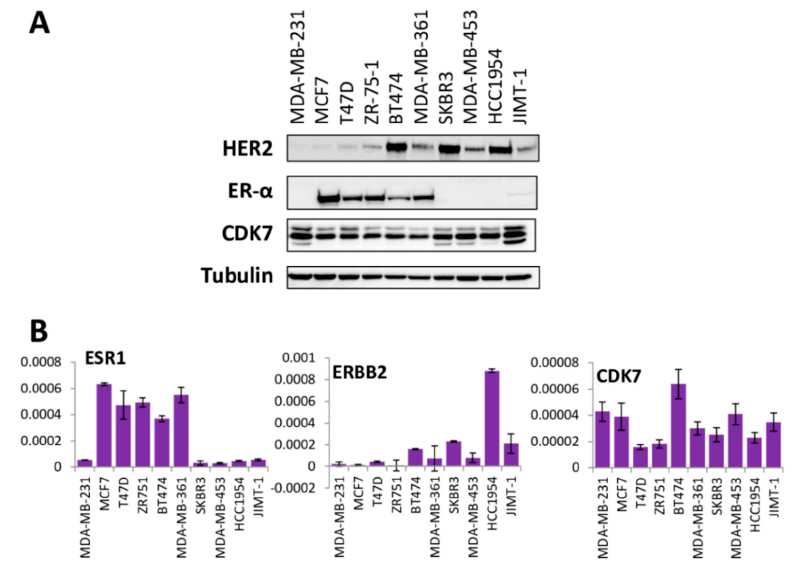
Figure 3. ER, HER2 and CDK7 expression in breast cancer cell lines. ( A ) Immunoblotting and ( B ) mRNA analysis of ER α (ESR1), HER2 (ERBB2) and CDK7 expression in a panel of cell lines representing multiple subtypes of breast cancer. mRNA represented as mRNA expression level normalized to GAPDH mRNA expression in sample. Cells 2020 , 9 , 638